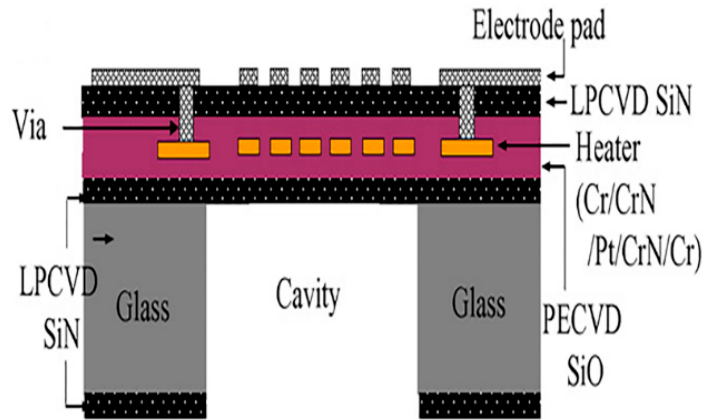
Figure 4. Structure diagram of glass-based micro-hotplate [46].